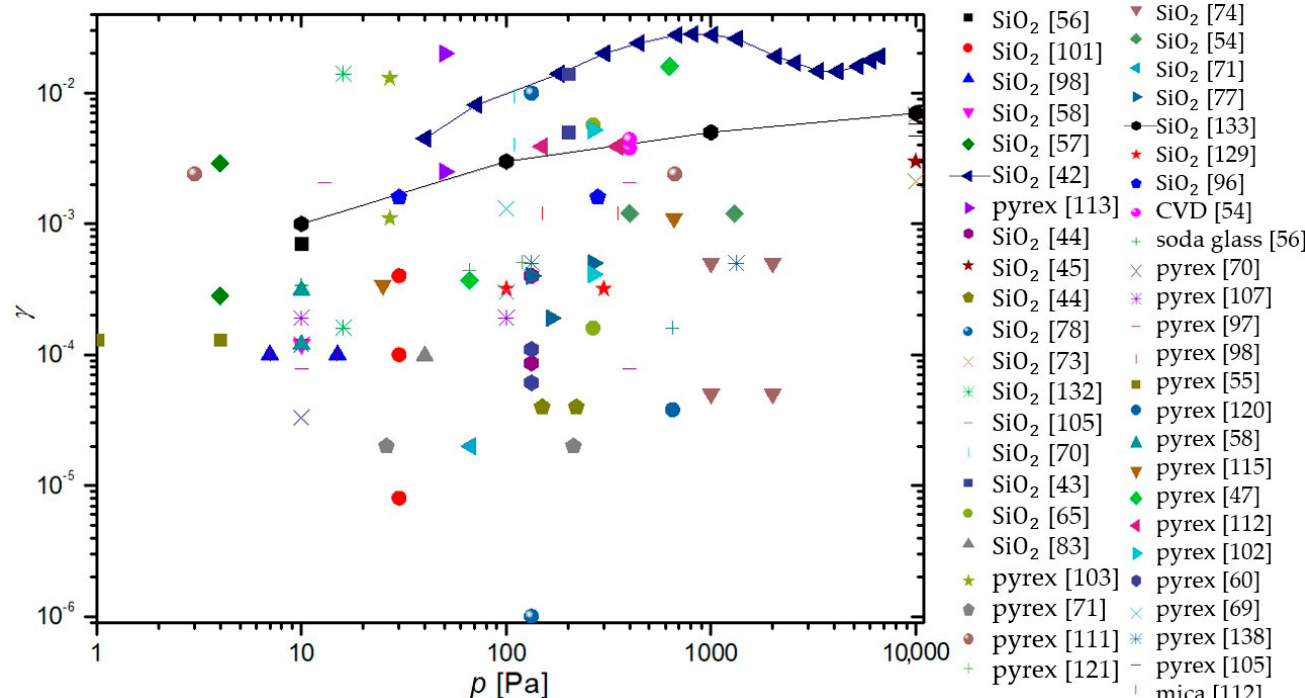
Figure 22. Recombination coefficient ( 𝛾 ) of neutral oxygen atoms versus pressure ( 𝑝 ) for glass sur- faces.